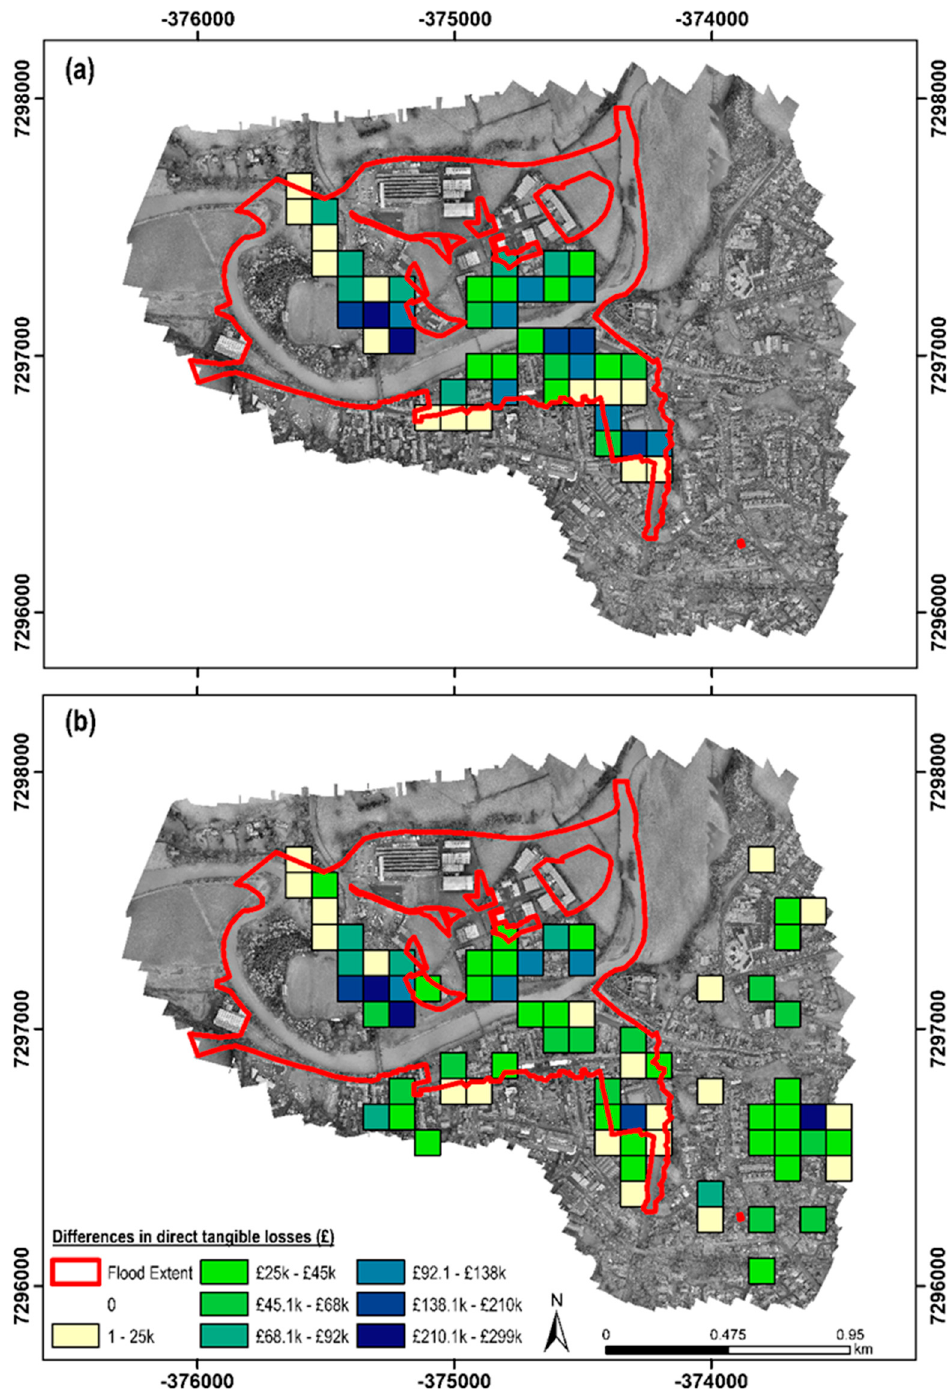
Figure 7. Difference in direct tangible losses (£) when considering damage to property for affected households with and without resistance measures in place after Desmond floods (5–6 December 2015) for Cockermouth (Cumbria, UK) based on ( a ) the classic loss adjustment approach that relies on the Environment Agency fluvial flood extent and ( b ) the UAV loss adjustment approach. The methodology used for the estimation of the direct tangible losses was based on [31,32]. The losses (without VAT or other indirect taxes) are in GBP at 2016/17 prices.